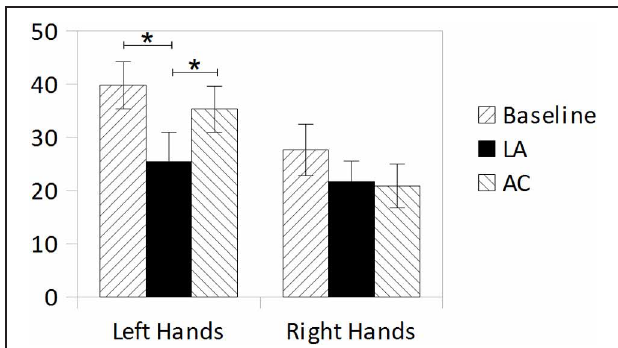
FIGURE 3 | Mean error rates (%) in the hands-test during Baseline, Limb Activation, and Alertness conditions for depicted left hands (left bars) and depicted right hands (right bars). Error bars indicate standard errors of the mean